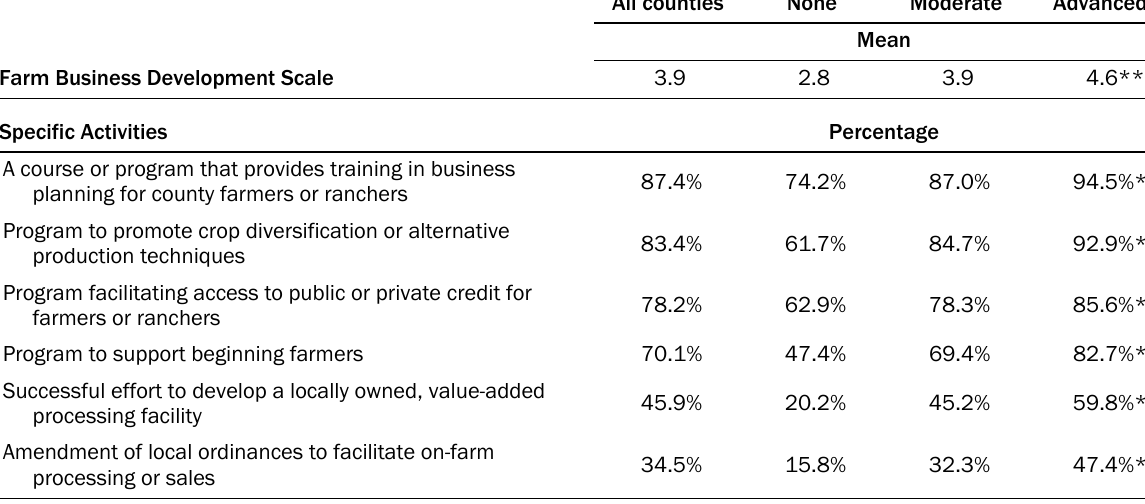
Table 3. Farm Business Development Activity by Level of Organization ( N